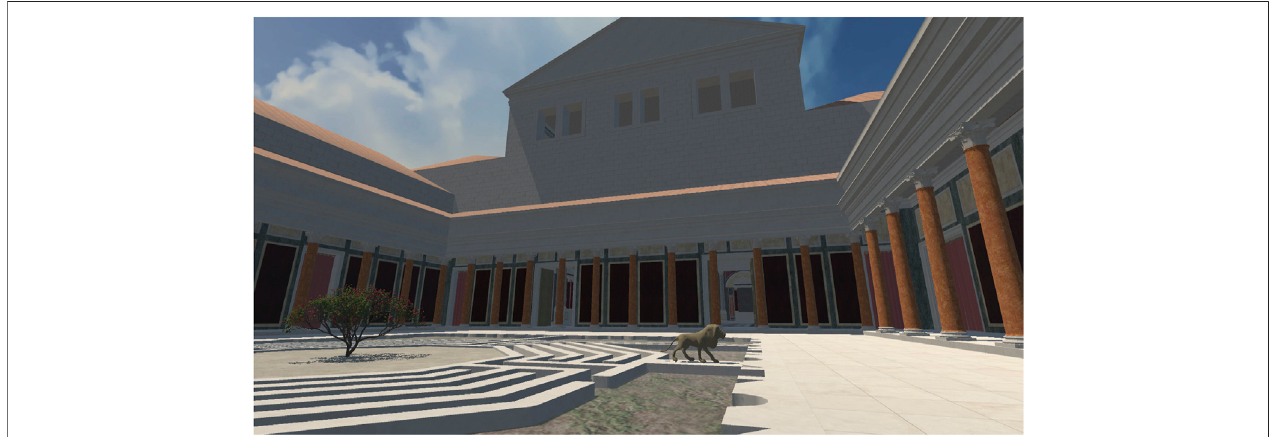
FIGURE 1 | First-person view of the virtual environment representing the Ancient Rome.